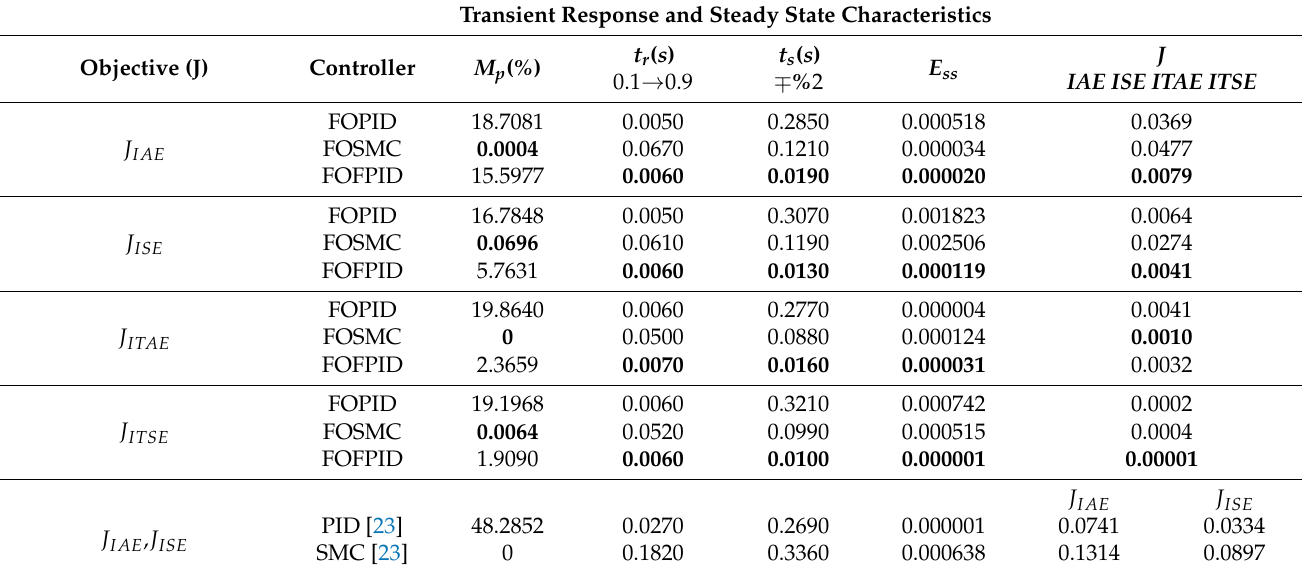
Table 4. Comparative dynamic response specifications on different controllers for the Maglev